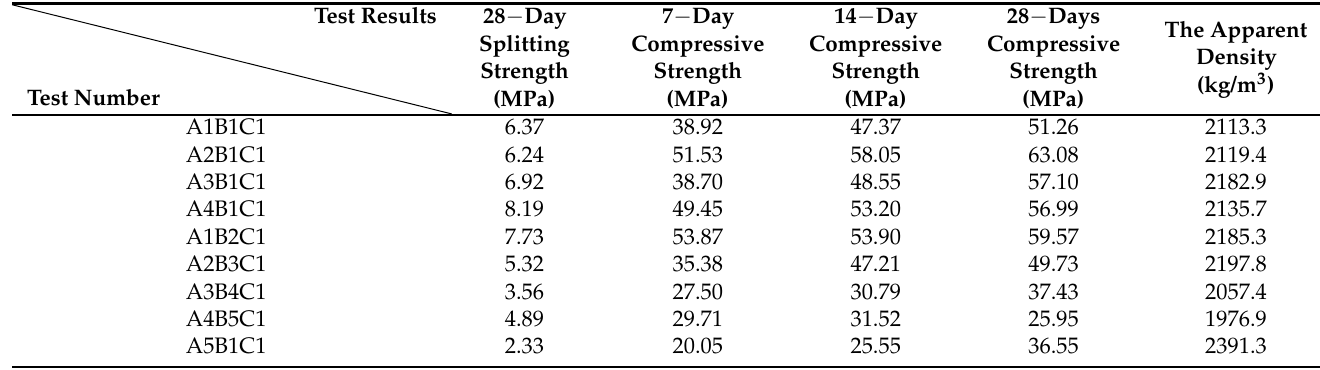
Table 2. Orthogonal test results.